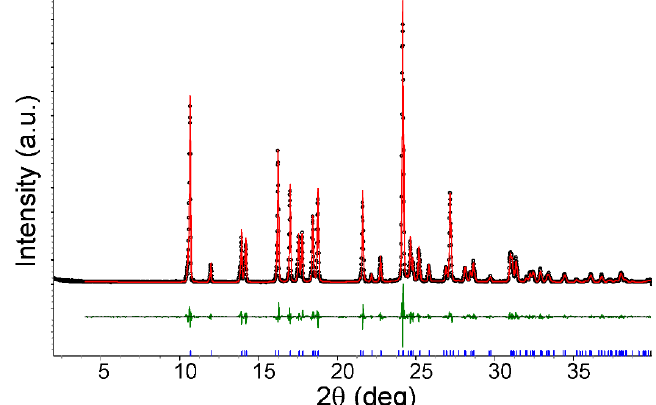
Figure 7. Pawley fit ( R wp = 10.03%, R exp = 5.57%, R p = 7.80%, gof = 1.80) of the PXRD